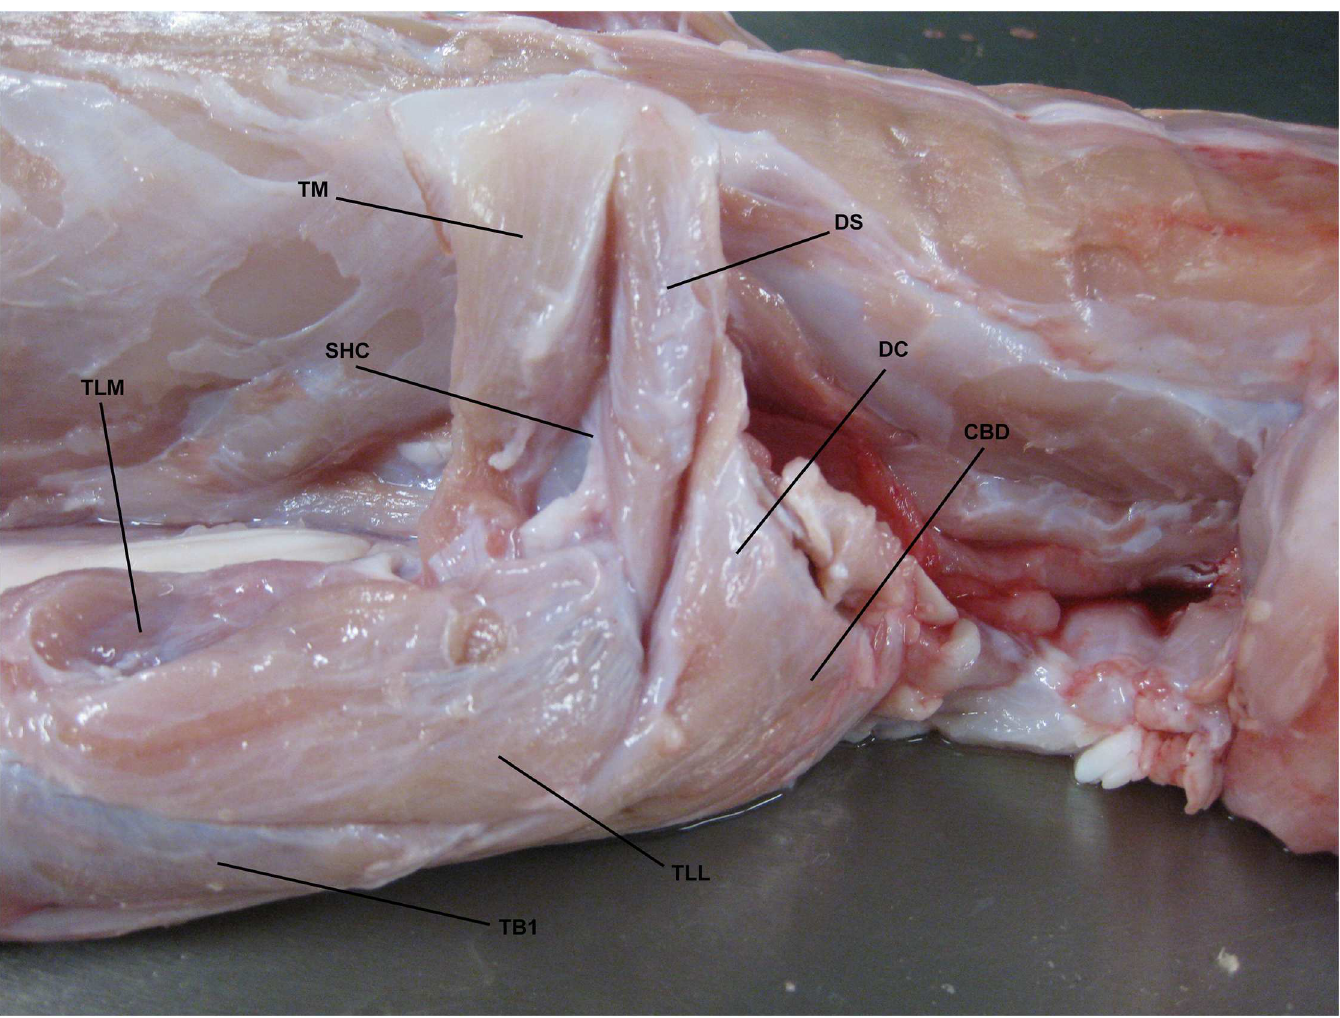
Fig 3. Fresh-tissue dissection with muscles identified around shoulder. Lateral view of right shoulderregionof Crocodylusporosus (XCb Cp5). TM: Teres major , DS: Deltoideus scapularis , SHC: Scapulohumeralis caudalis ,DC: Deltoideus clavicularis , CBD: Coracobrachialis brevis dorsalis , TLM: Triceps longusmedialis ,TLL: Triceps longuslateralis ,TB1: Triceps brevis 1 .